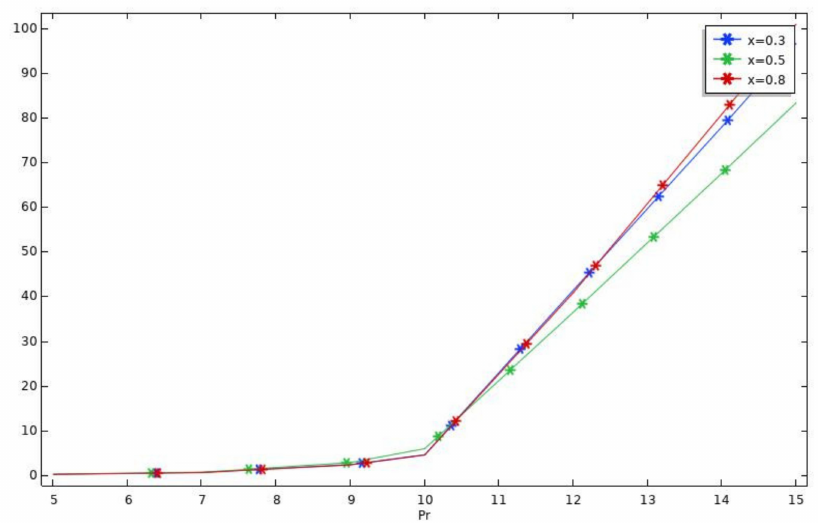
Figure 14. Kinetic energy graphs against various cutlines for varying ( Pr )